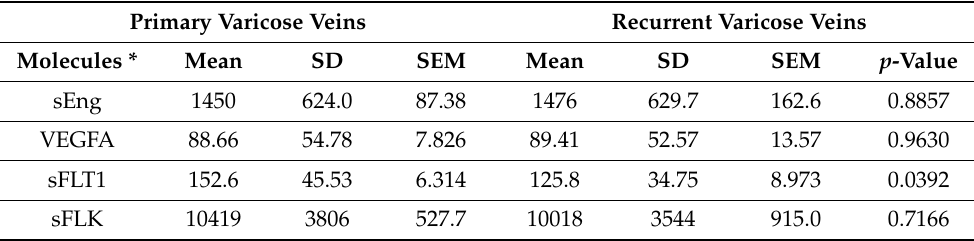
Table 3. Serum levels (pg/mL) of the molecules investigated. Primary Varicose Veins Recurrent Varicose Veins Molecules